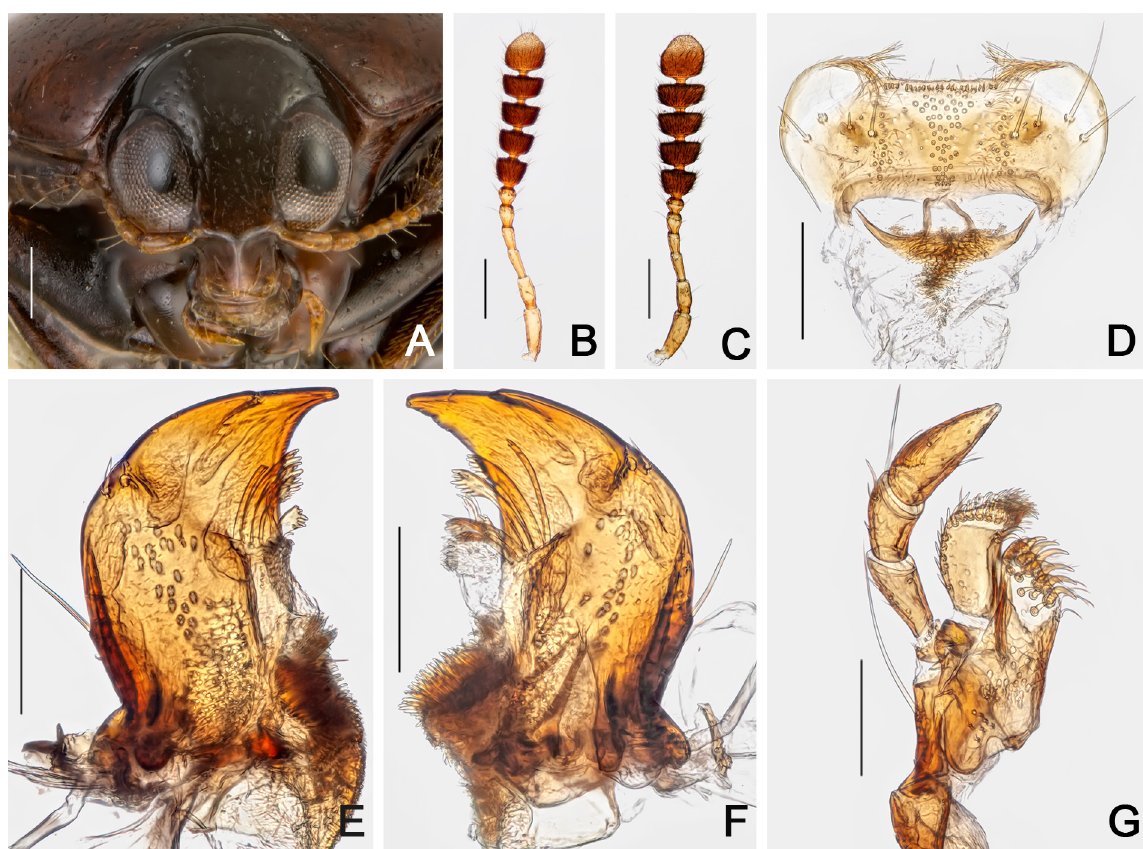
Fig. 23. Cyparium loebli sp. nov. A . Holotype, ♂ (CELC), frontal view. B–C . Antennae. B . Paratype, ♂ (CELC). C . Paratype, ♀ (CELC). D–G . Paratype, ♂ (CELC). D . Labrum. E . Left mandible. F . Right mandible. G . Maxilla. Specimens collected at Mata do Paraíso, Viçosa (MG, Brazil). Scale bars: A–C = 0.2 mm; D–G = 0.1